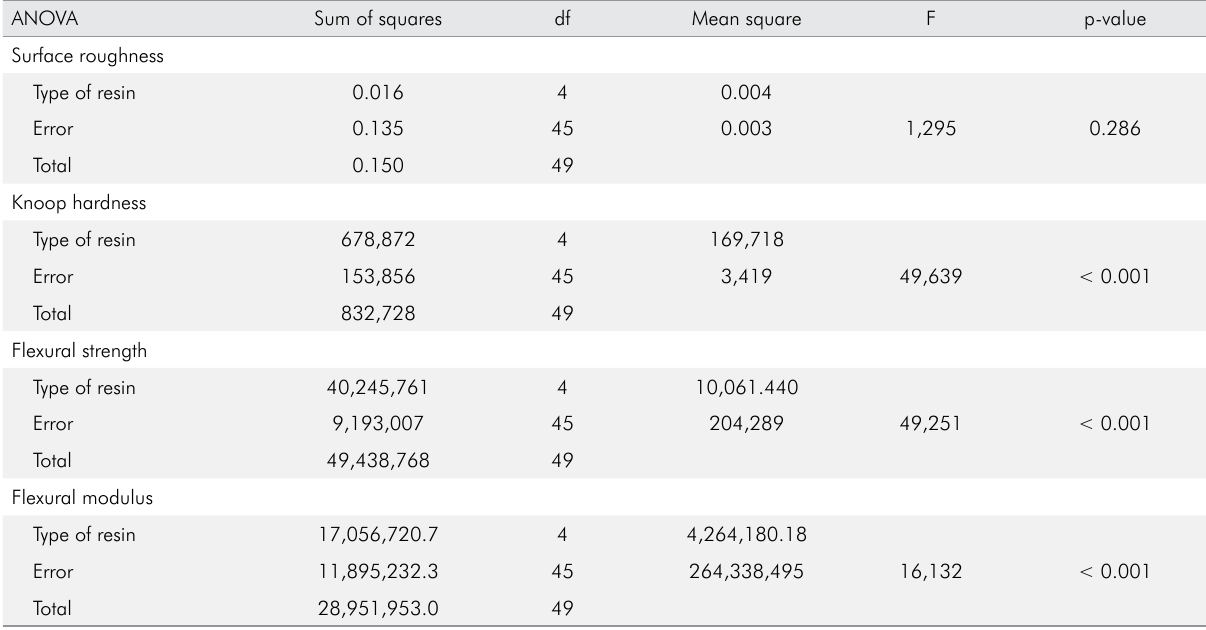
Table 2. One-way ANOVA results of surface roughness, microhardness, flexural strength, and modulus of elasticity tests. ANOVA